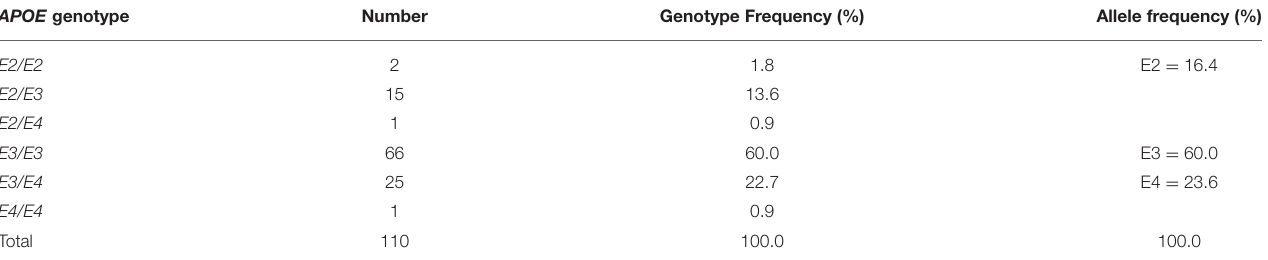
TABLE 2 | APOE genotype and allele frequencies in the study population. APOE